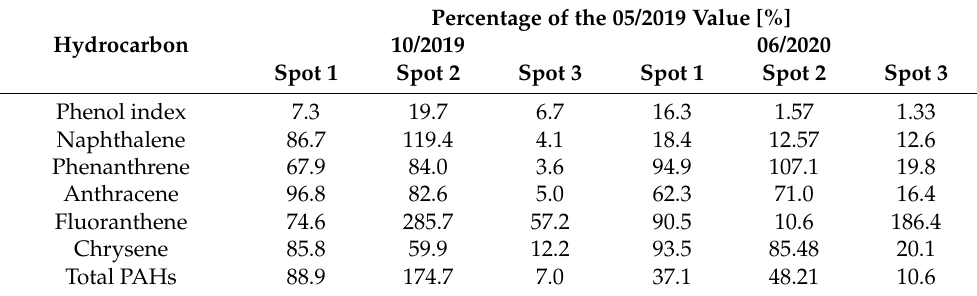
Table 4. Percentage of the hydrocarbons in comparison to initial values before consortium